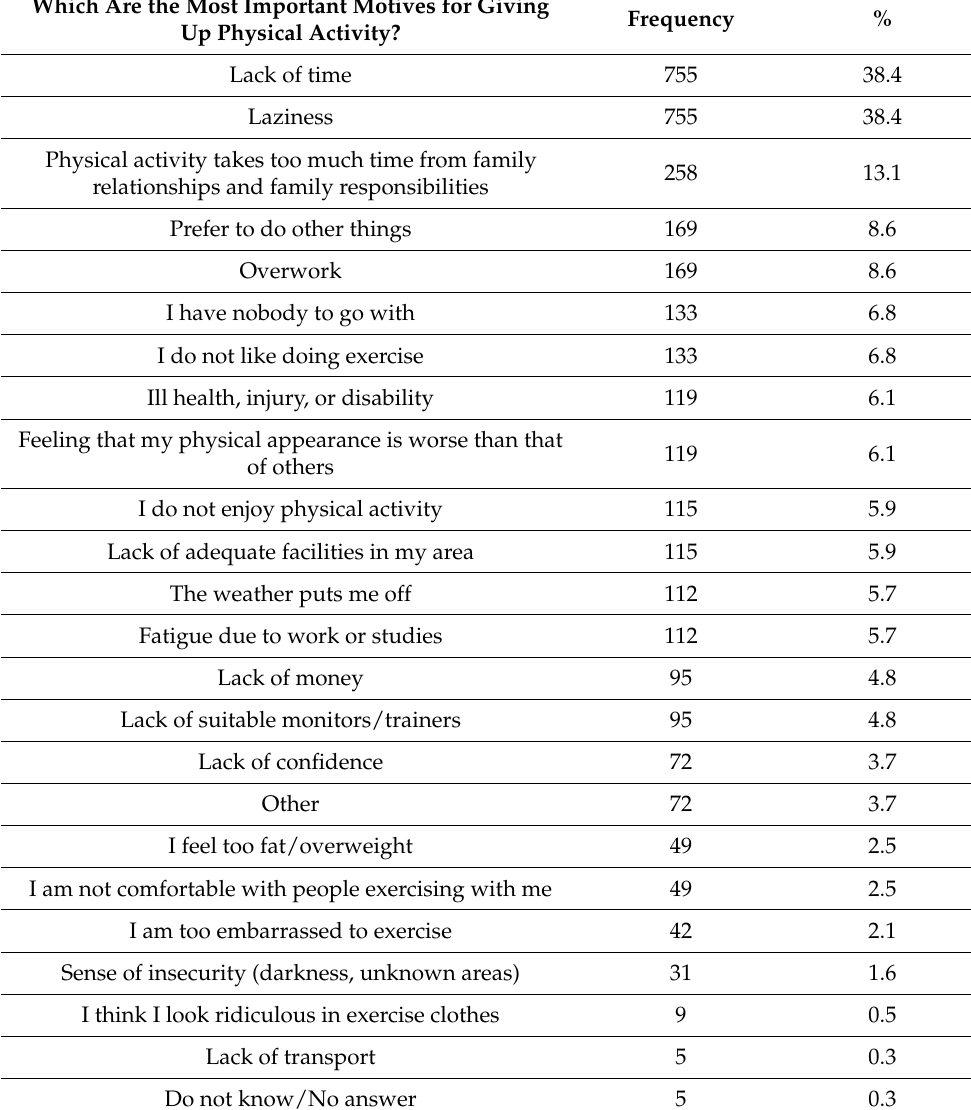
Table 4. Inactive group participant responses concerning the motives for giving up PA (total n of responses =